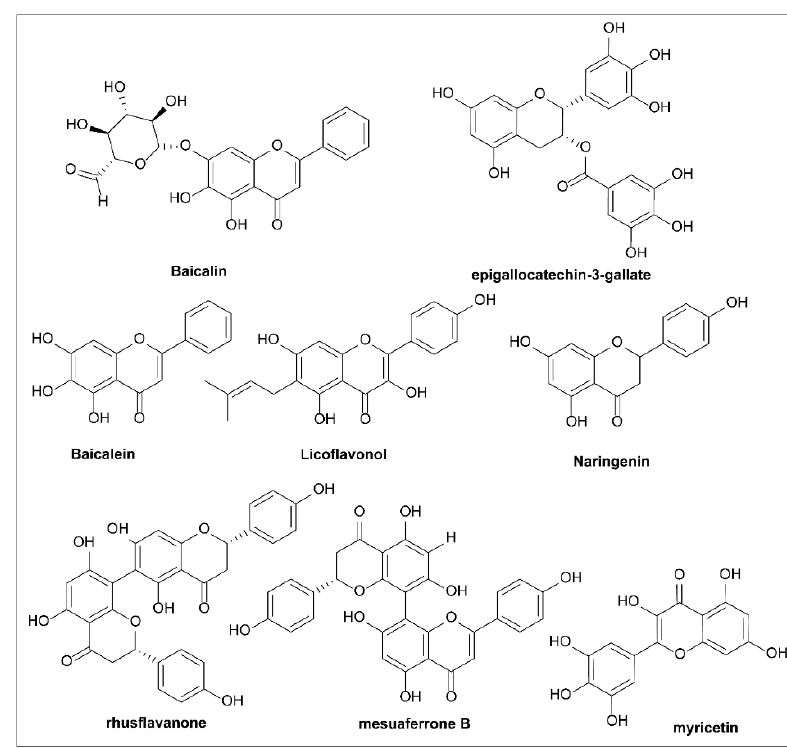
Figure 13. Structures of flavonoids.